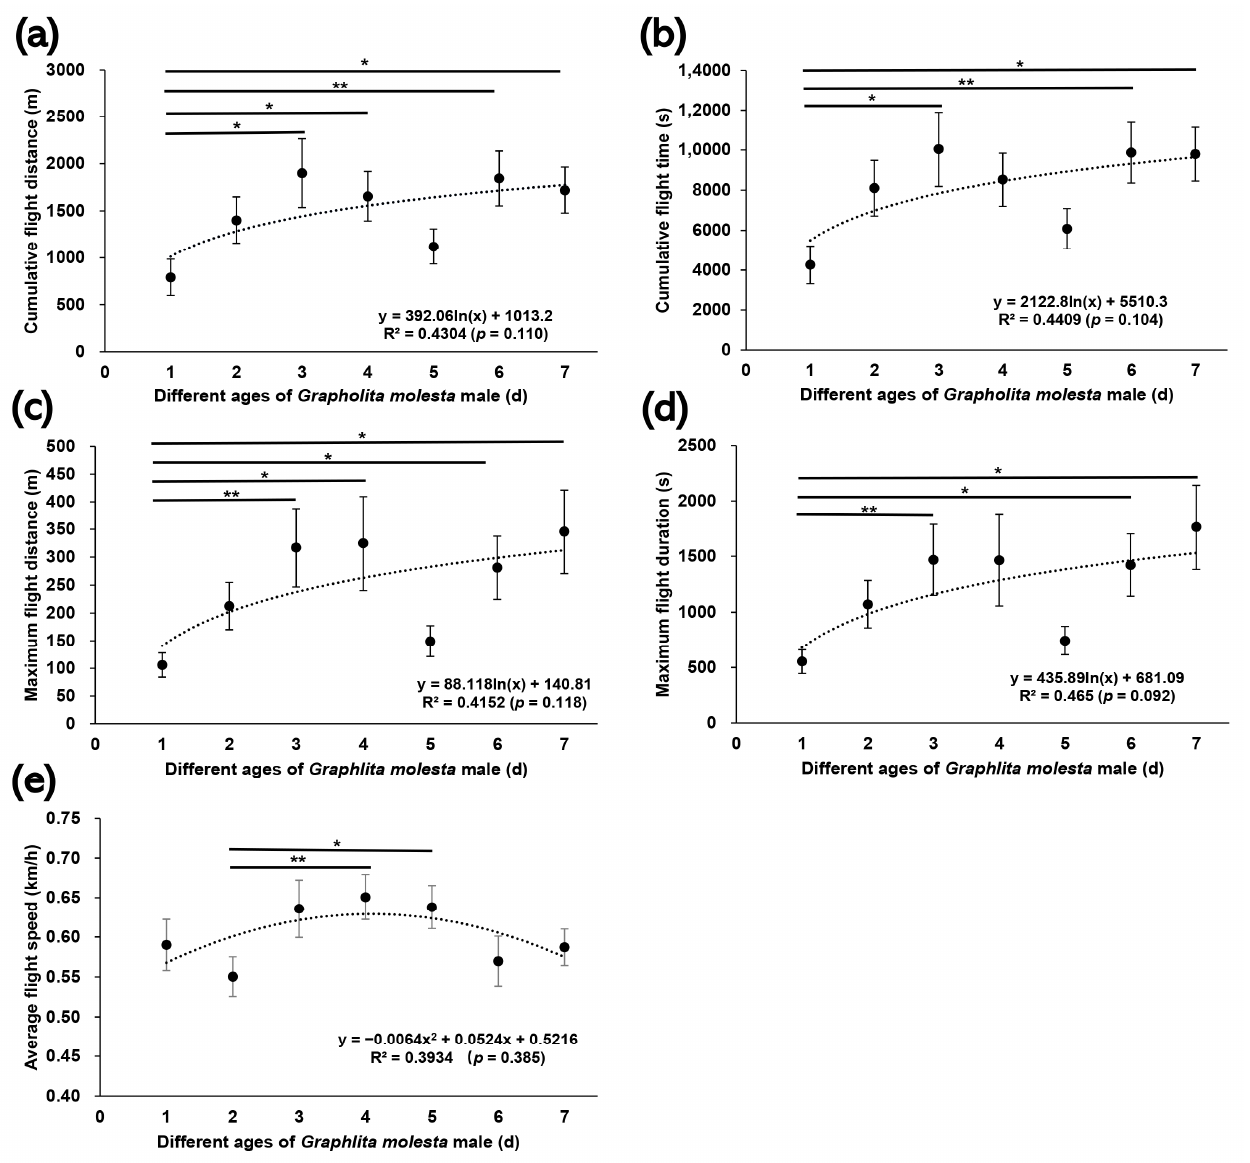
Figure 5. Cumulative flight distance ( a ) , cumulative flight time ( b ), maximum flight distance ( c ), maximum flight duration ( d ), and average flight speed ( e ) of male Grapholita molesta of different ages. The data are shown as the mean ± standard error. **, significant difference at p < 0.01; *, significant difference at p < 0.05.